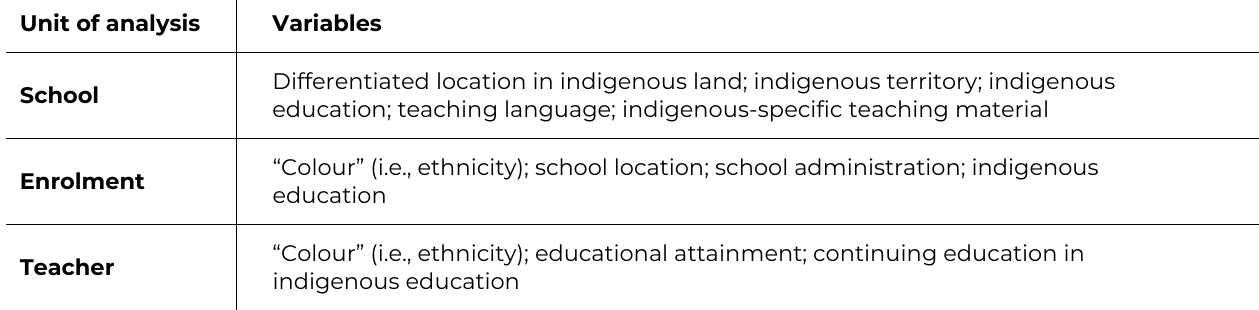
Table 1. School Census: Variables considered in the analysis Unit of